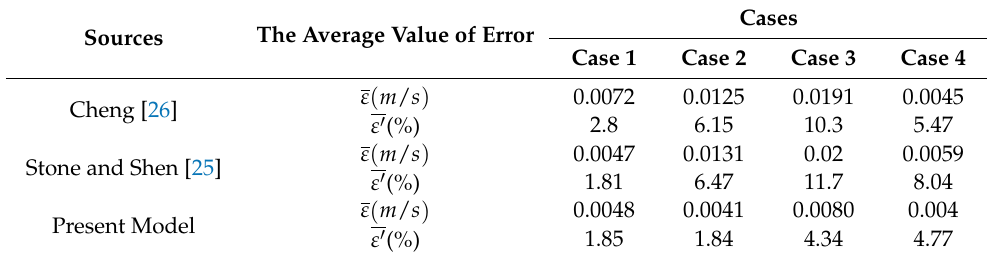
Table 2. Error statistics of the transverse distribution of the water depth-averaged streamwise velocity calculated by the